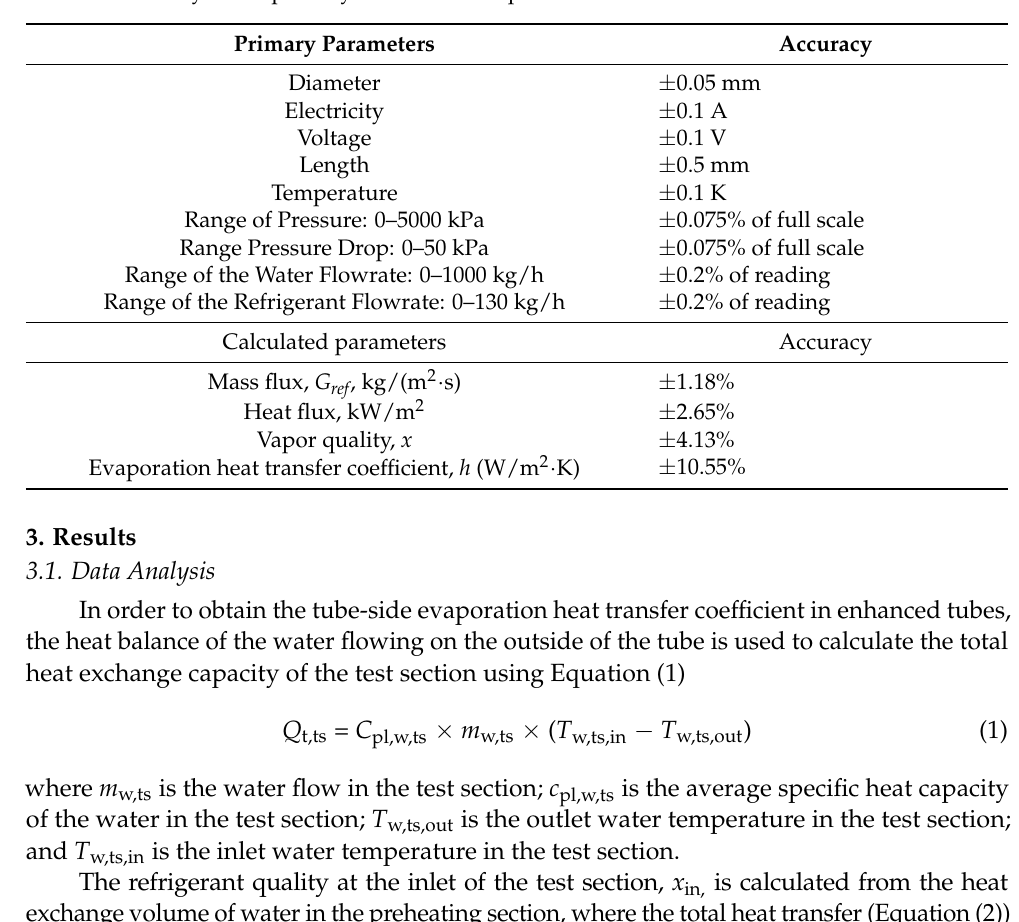
Table 2. Accuracy of the primary and calculated